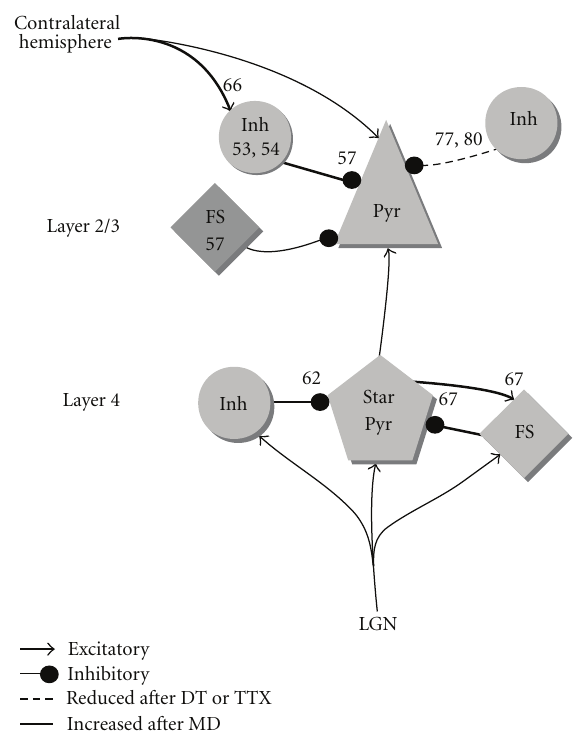
Figure 2: Documented changes in inhibition in V1 after monocular deprivation (MD), dark treatment (DT) or intraocular TTX injection during the critical period. Numbers correspond to the references that measured the change in the responses or synaptic strength of interneurons. Pyr is pyramidal cell, Star pyr is star pyramid neuron, Inh is interneuron, FS is fast-spiking interneuron. Light gray means shifted towards the open eye after MD. Dark gray is shifted towards the deprived-eye. All studies were done in binocular visual cortex, except for references [67, 77] which were done in monocular cortex and possibly reference [80], which left the exact location within visual cortex